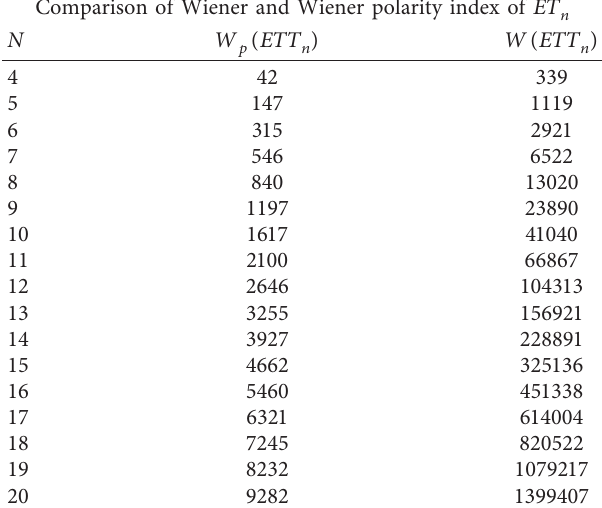
Table 1: Comparison of Wiener and Wiener polarity indices of the graph of triangular mesh network.